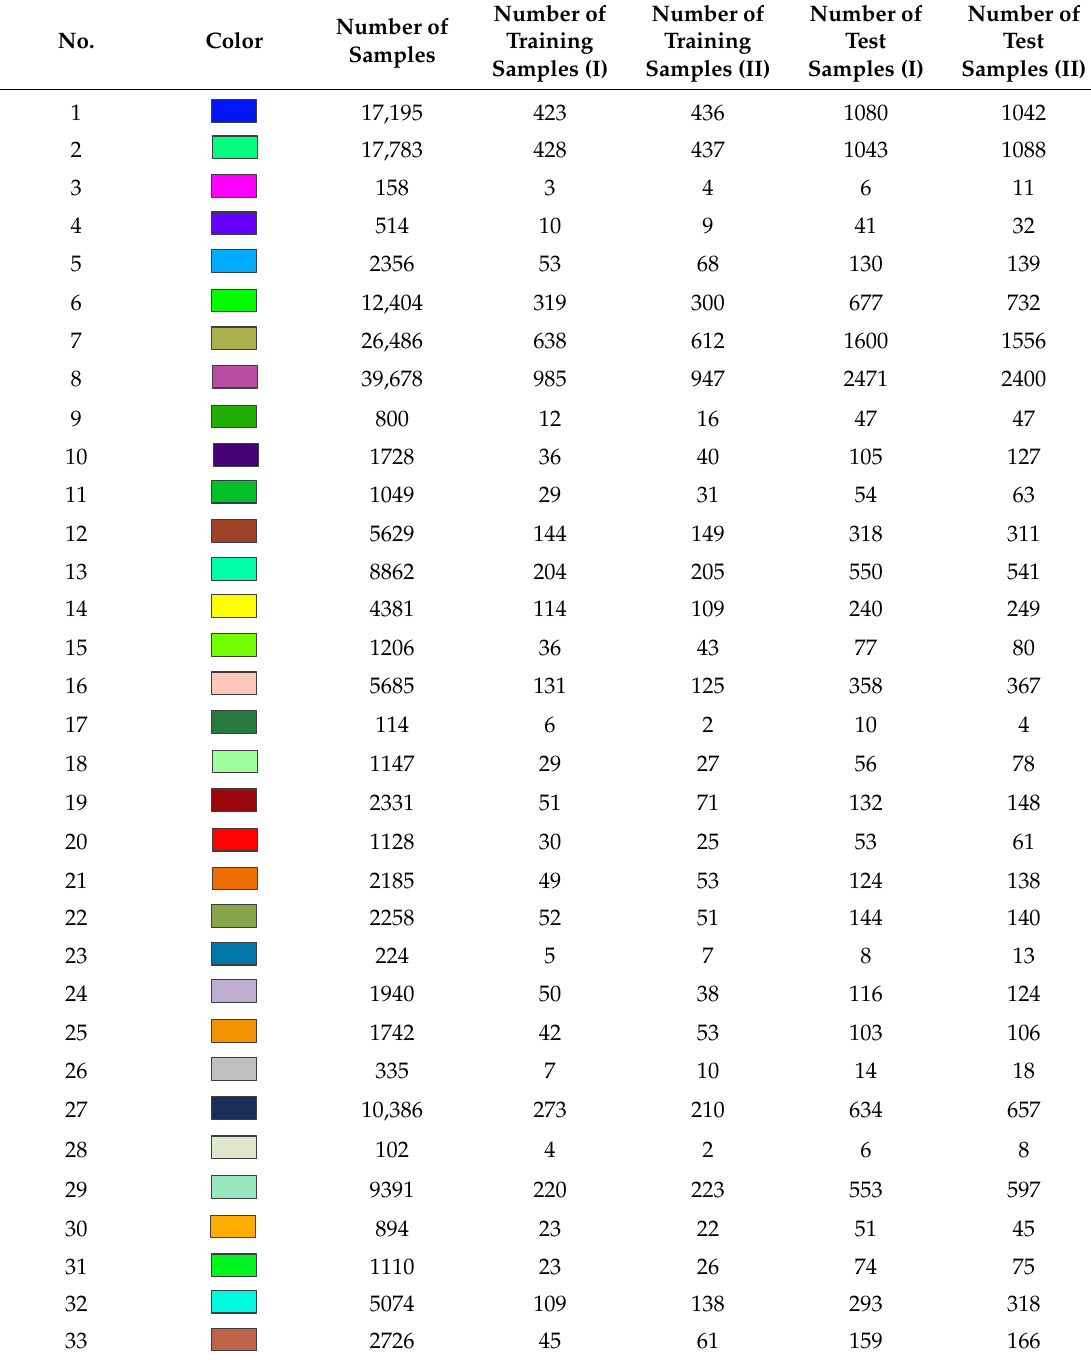
Table 1. The distribution of the 52 classes.